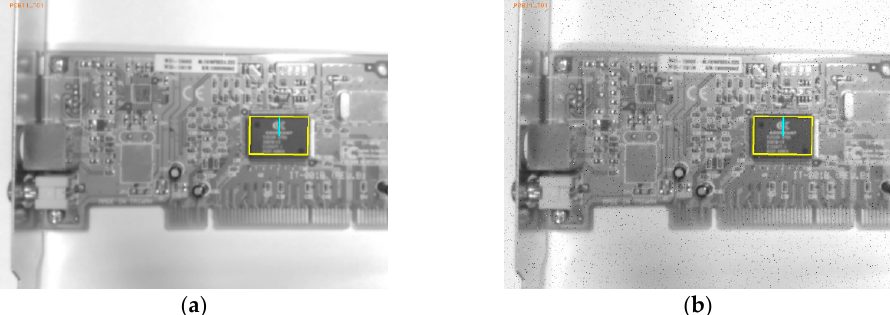
show the results for the test images (1280 × 960 pixels) with scales of 0.8, 0.9, 1.0, 1.1 and 1.2, test images (1280 × 960 pixels) with scales of 0.8, 0.9, 1.0, 1.1 and 1.2, respectively. Sensors 2020 , 20 , x FOR PEER REVIEW respectively.